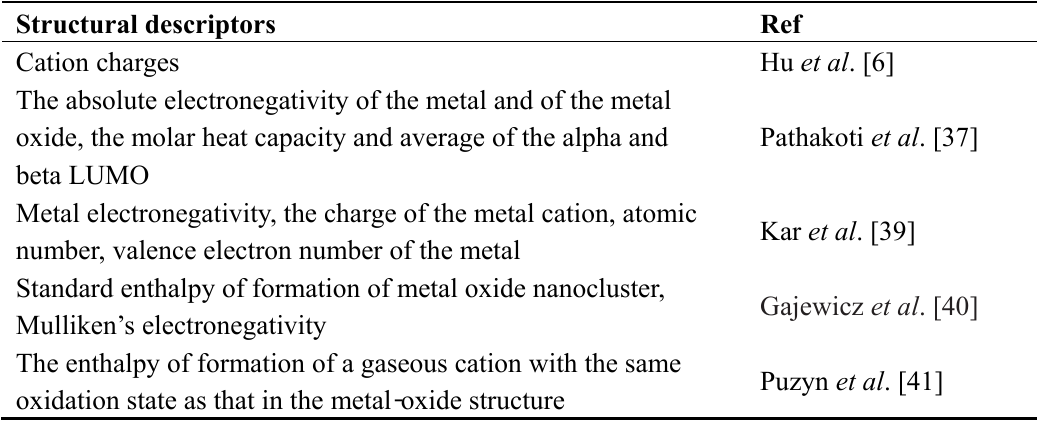
Table 3. Main theoretical structural descriptors used in some metal oxide QNAR